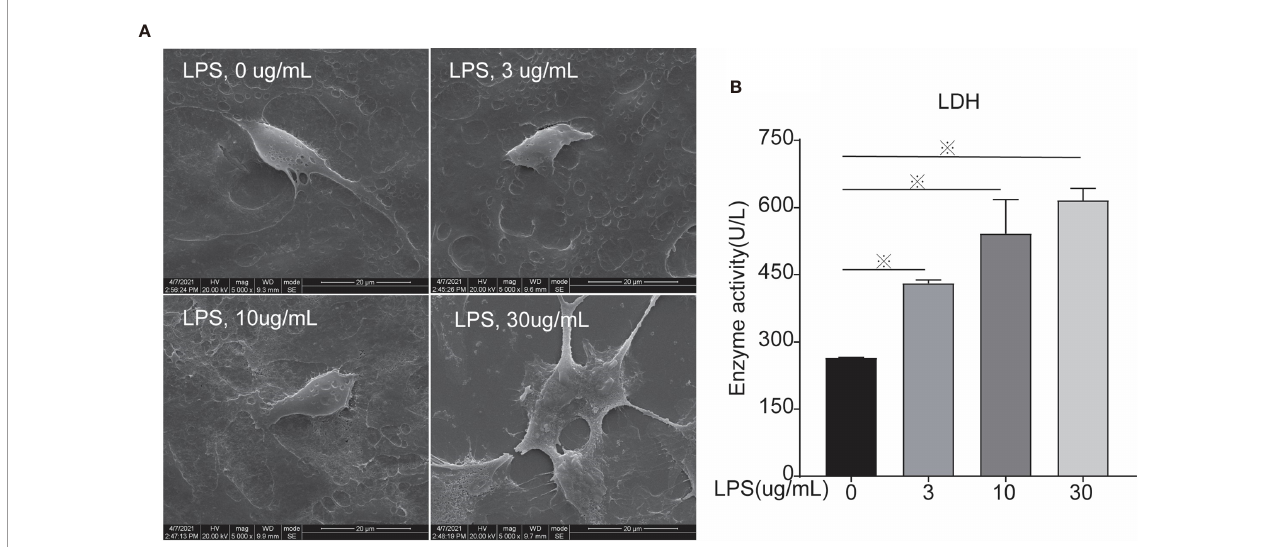
FIGURE 3 | Scanning Electron Microscopy and LDH activity of cells treated with different concentrations of LPS for 24 h. (A) Scanning electron microscopy, and (B) LDH. Each treatment had three samples (n = 3) and was repeated three times to reduce system errors; “ ※ ” means there was a signi fi cant difference ( P < 0.05 ) compared with negative control (LPS, 0 µg/ml); scanning electron microscopy photographing magni fi cation is 5,000 times, and the picture scale was 20 um.